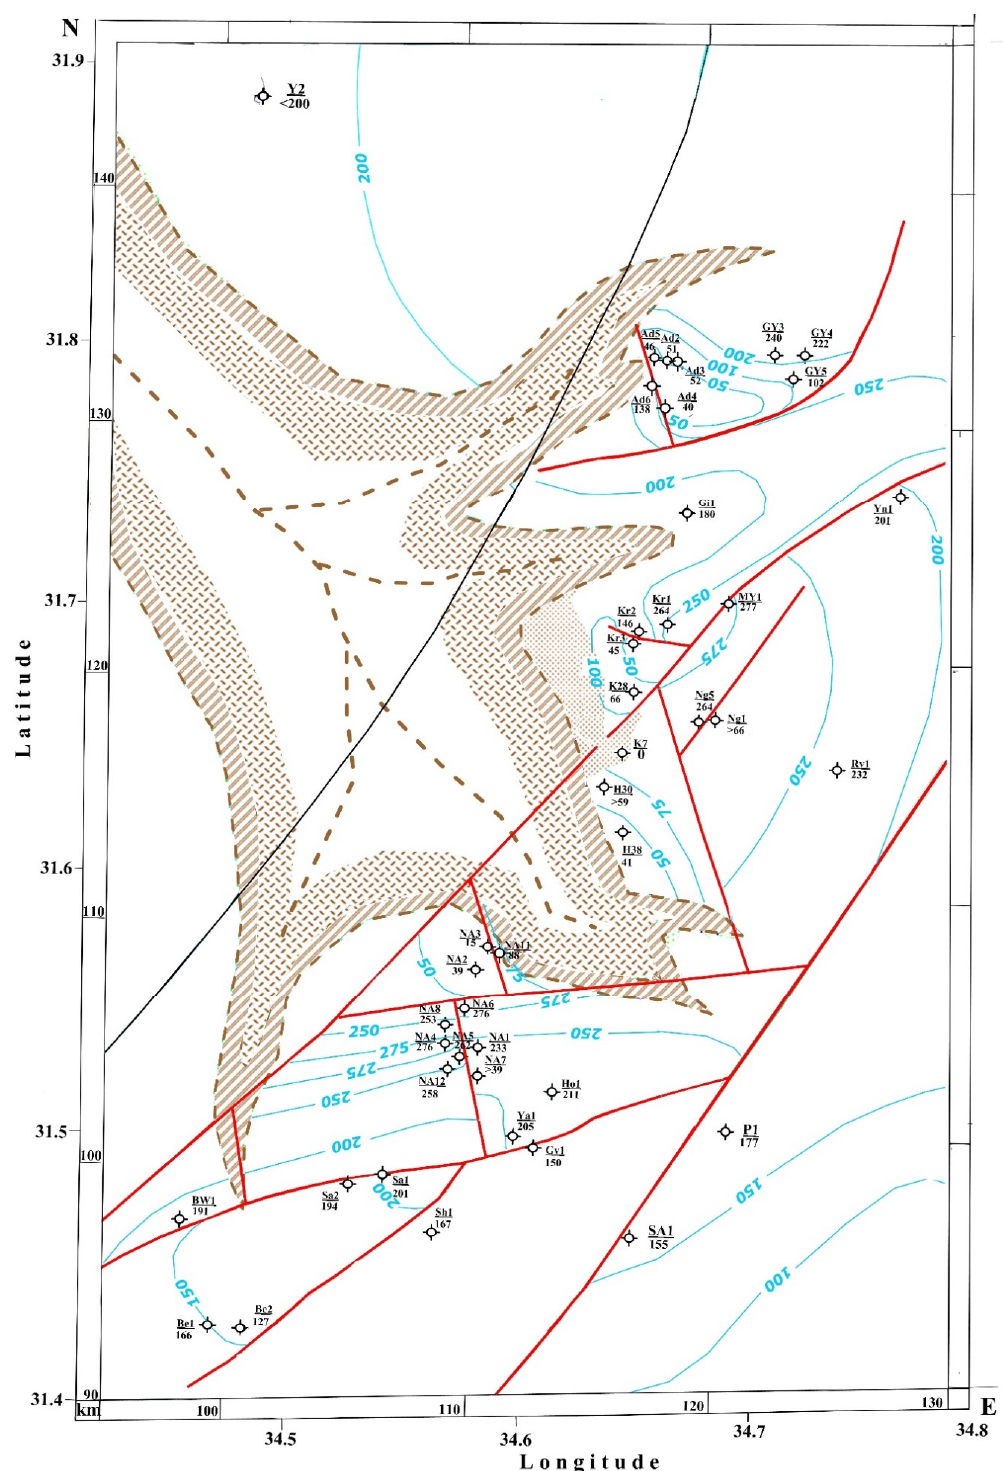
Figure 9. A map of the thicknesses of the Middle Oxfordian (Beer-Sheva Formation) of the Heletz– Ashdod oil field. The brown color shows the erosional canyon, and blue lines are the isopachs. Bore- hole abbreviations: see captions for Figure 2.